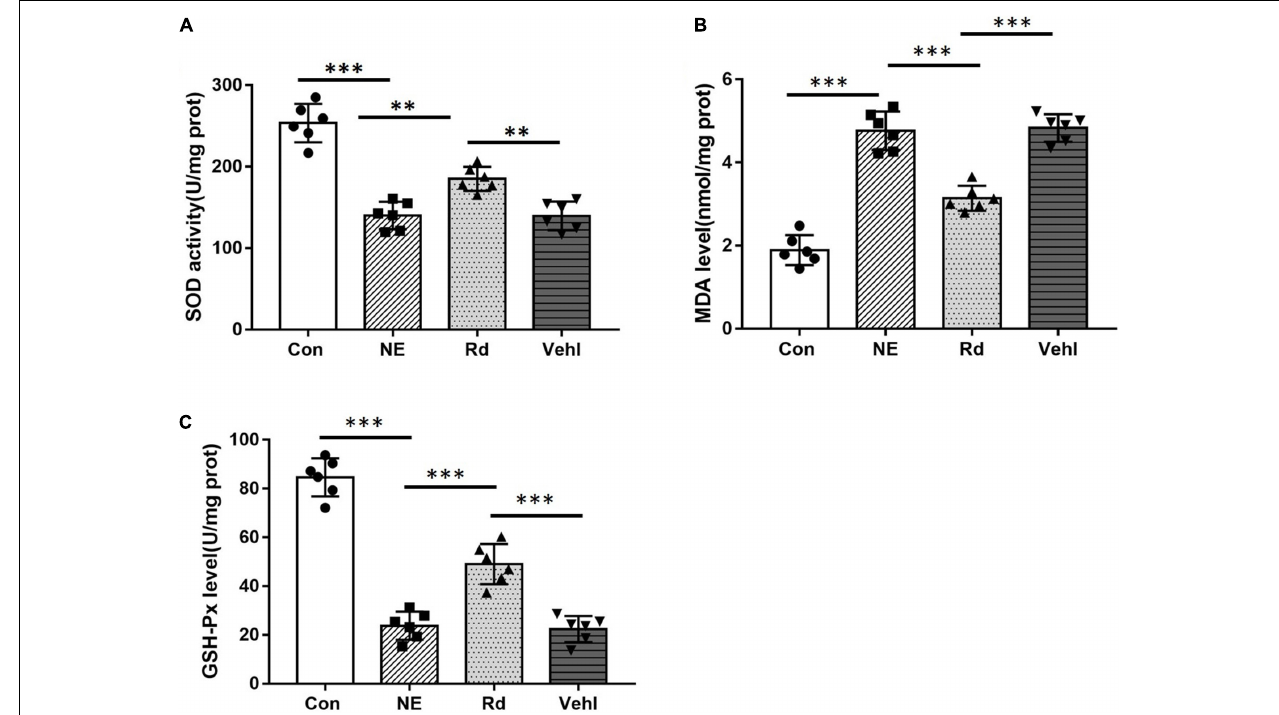
FIGURE 6 | SOD activity (A) and MDA (B) and GSH-Px (C) levels in the four groups after noise exposure. ** p < 0.01, *** p < 0.001.